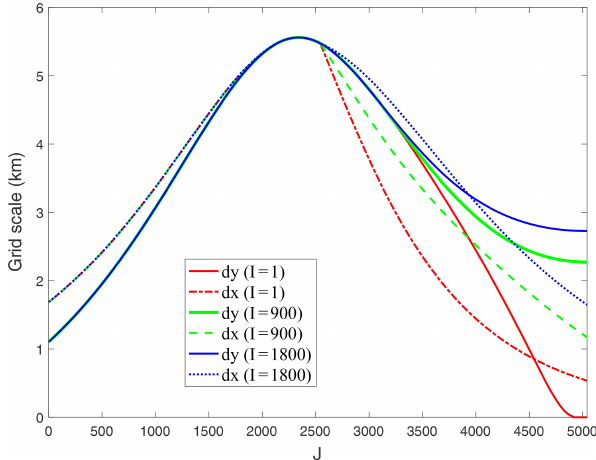
Figure A2. Grid sizes along the “meridional” grid lines for TS005 ( I and J dimensions are 7200 and 5040). Three typical lines are chosen: I = 1, I = 900 (1 / 8 in the I direction), and I = 1800 (1 / 4 in the I direction). Grid sizes in both the I and J directions retain continued changes. The corresponding grid lines are also shown in Fig. 2 with the same color coding. Note that when I = 1, d y (merid- ional grid size) approaches zero when J is close to the northern end ( J = 5400), which does not affect the model’s time stepping since it is near the grid pole that resides on